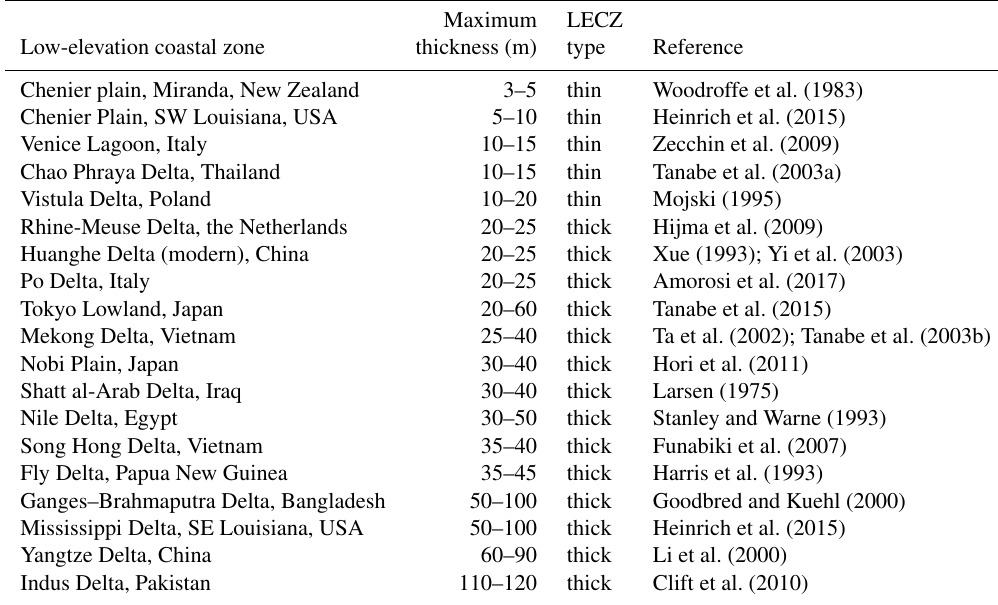
Figure 4. Schematic dip-oriented cross section comparing the depth of tide-gauge benchmarks and GNSS station foundations to the local depth to the Pleistocene surface. Sites are arranged by increasing depth of the Pleistocene surface. Note that two GNSS stations have minimum foundation depths (see Table 2), indicated here by small, downward-pointing arrows. See Fig. 2 for the location of geographic areas. Table 3. Holocene sediment thicknesses of LECZs around the world, measured close to the shoreline where coastal strata tend to be the